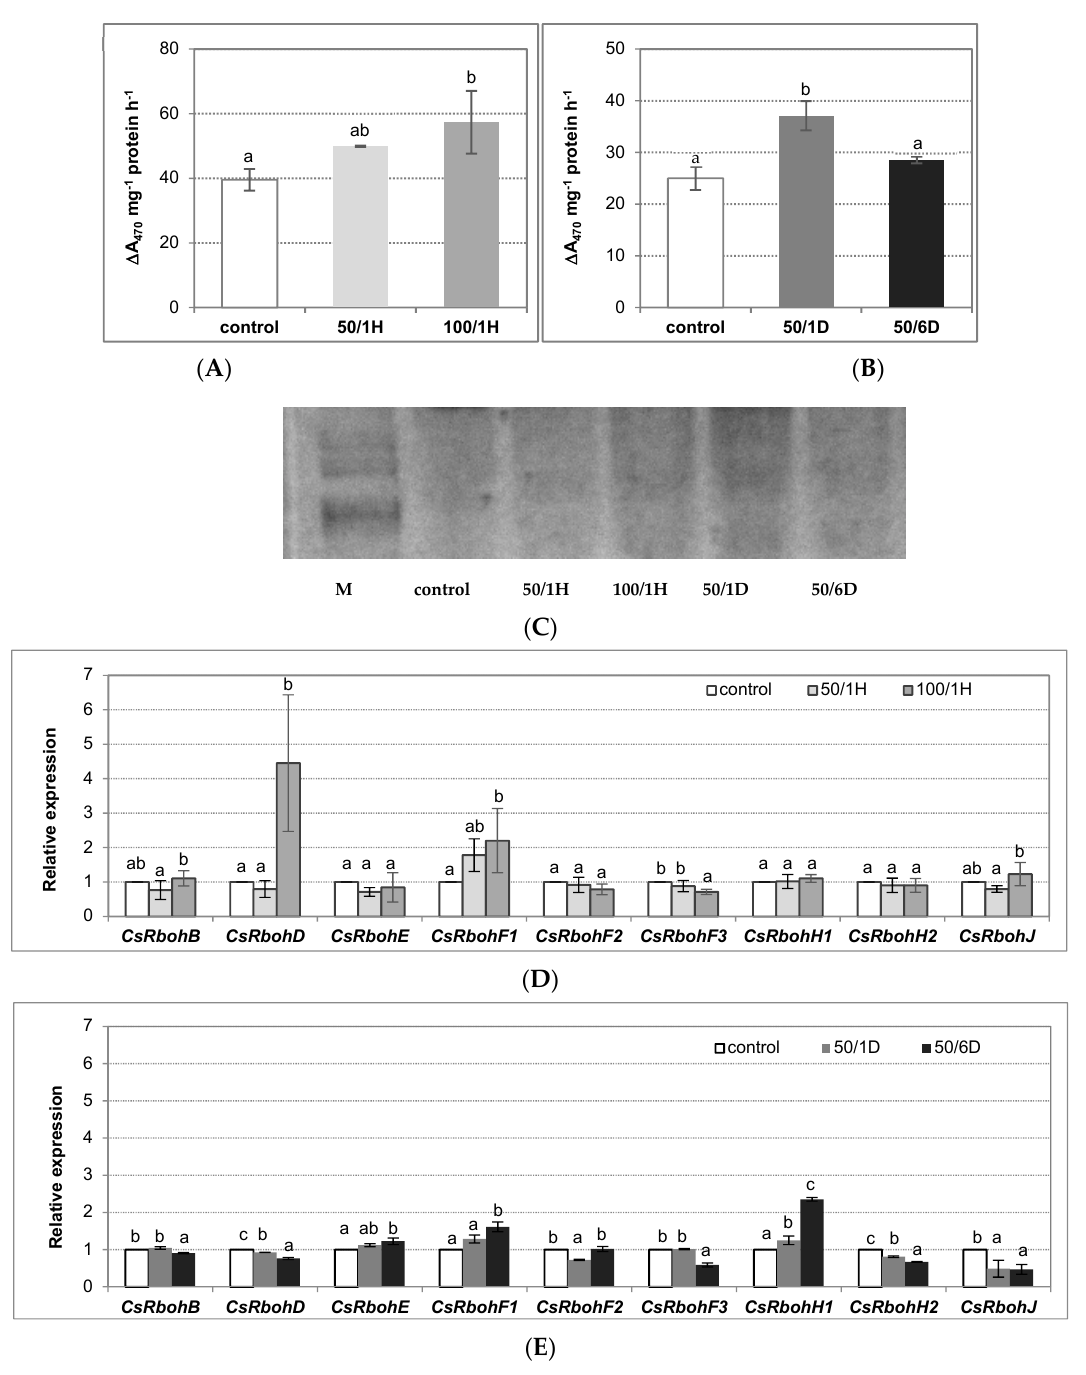
Figure 2. NADPH oxidase catalytic activity ( A , B ), in-gel activity( C ), and relative expression of CsRboh genes ( D , E ) in the tissues of cucumber roots exposed to salinity. The cucumber seedlings were treated with: ( A , C , D ) 50 mM or 100 mM NaCl for 1 h (50/1H and 100/1H, respectively) and ( B , C , E ) 50 mM NaCl for 1 or 6 days (50/1D and 50/6D, respectively). The plasma membrane vesicles were isolated from the cucumber roots to determine both catalytic ( A , B ) and in-gel ( C ) NADPH oxidase activity, as described in Materials and Methods. ( A , B ) The presented results are the means ± SD of three independent experiments, with each experiment performed in triplicate, and are expressed as the Δ A 470 of formazan XTT mg − 1 protein h − 1 . ( C ) Gel image with blue formazan bands detected using the NBT method. The plasma membrane proteins were subjected to native PAGE, and examined for their ability to generate O 2 − by reduction of nitroblue tetrazolium. The bands detected in the gel were due to NADPH-dependent NBT reduction by O 2 − radicals. The gel image shown is representa- tive of three independent replications of the experiment; M—molecular weight marker. ( D , E ) The total RNA was isolated from the cucumber roots, and real-time PCR analysis was performed with